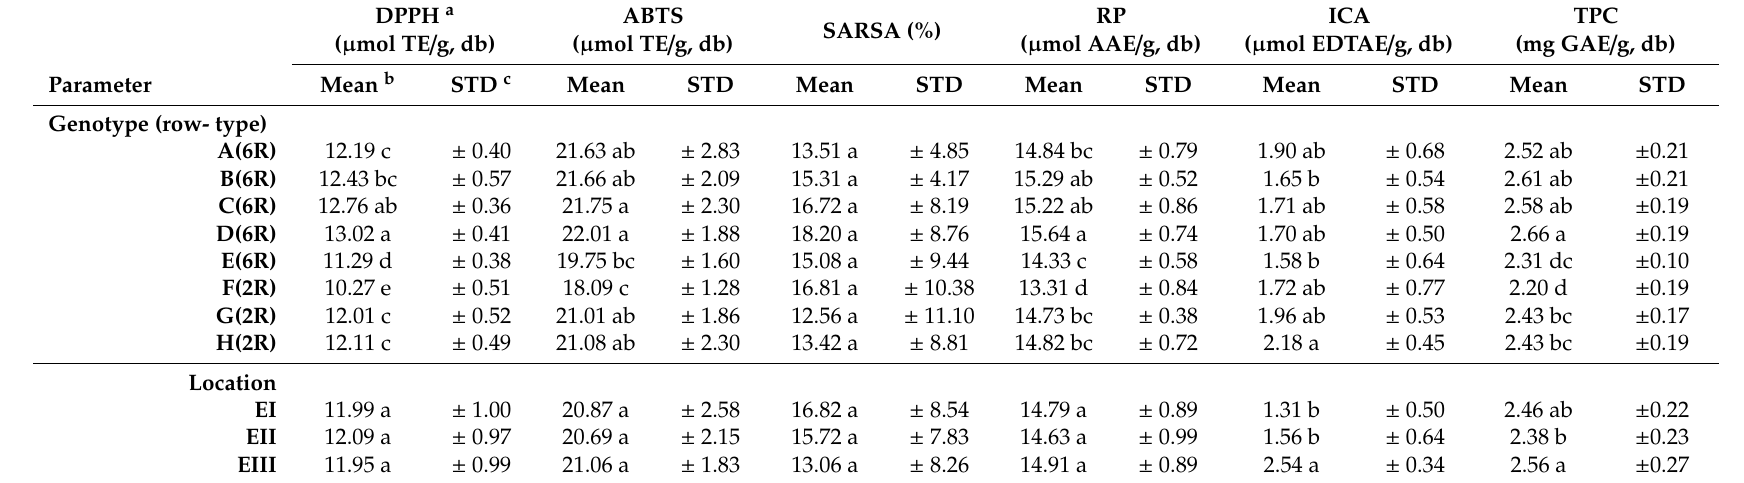
Table 1. Mean and Range of Antioxidant Activities and Total Phenolic Content as A ff ected by Barley Cultivar and